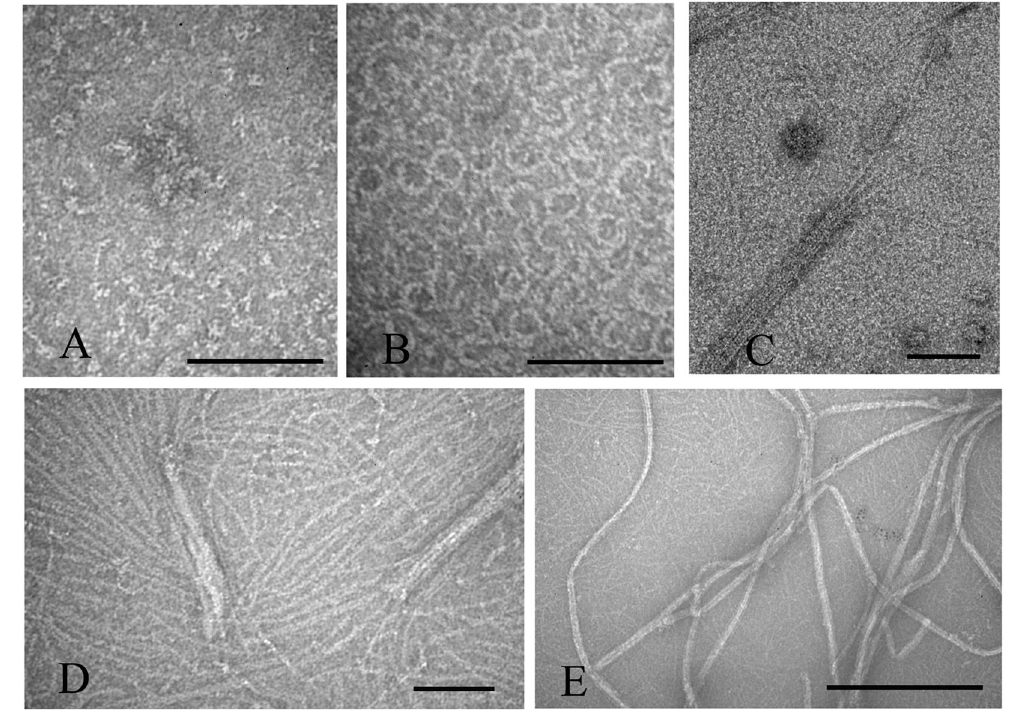
Figure 5. Assembly of FtsZ plus FtsA or FtsA * , at pH 7.5. ( A , B ) Assembly in 0.5 mM GDP of 15 µ M FtsZ plus 10 µ M FtsA ( A ) or 10 µ M FtsA * ( B ). FtsA * caused assembly of abundant minirings. ( C – E ) Assembly in 1 mM GTP of 10 µ M FtsZ plus 10 µ M FtsA * without ATP ( C , D ), and with 1 mM ATP ( E ). Bars are 100 nm in A – D and 500 nm in E